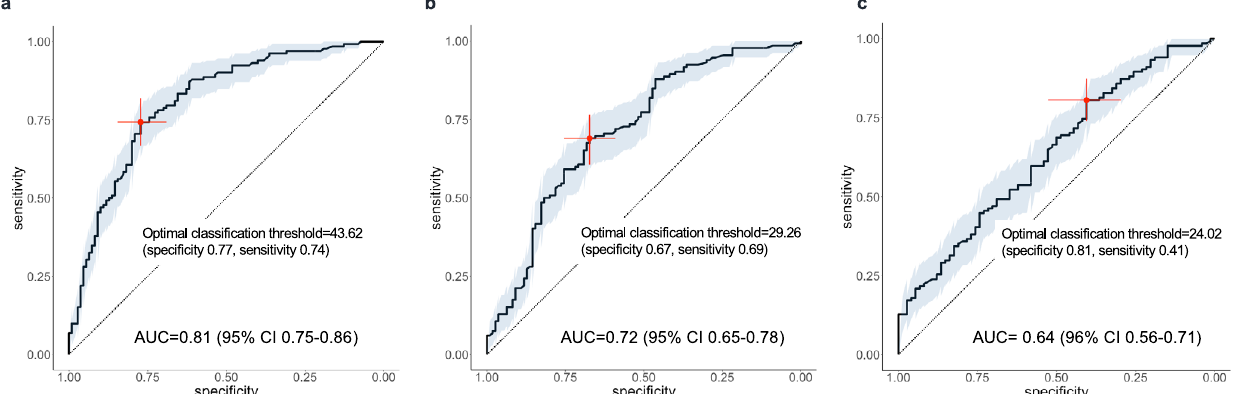
Fig. 5 Discriminative performance of the PREDIGT Score based on self-reported questionnaires in a screening-adapted version (Model 2; Step 1). In a – c ROC curves representing the discriminative performance of: a a questionnaire derived from DeNoPa cohort using DeNoPa participants; b a questionnaire derived from the PPMI + FOUND cohort using DeNoPa participants; and c a questionnaire derived from PPMI + FOUND using PPMI + FOUND participants. Acronyms of cohort names as listed in Figs. 1, 2; AUC area under the ROC curve, CI con fi dence